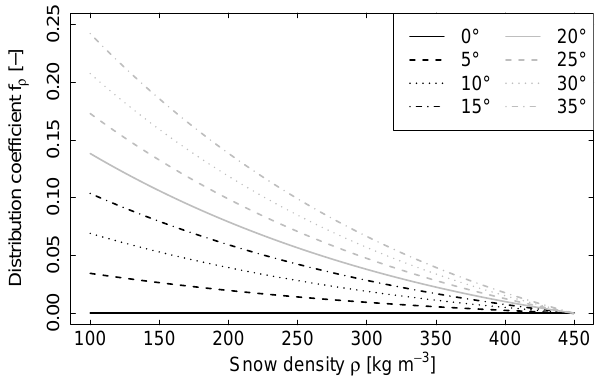
Figure 4. Shapes of the distribution coefficient in dependency of different slope angles and snow densities.